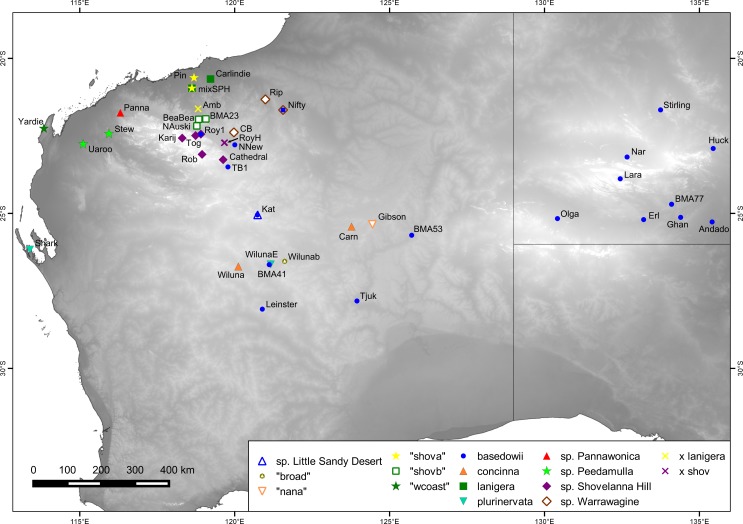
Sampling locations for populations from the Triodia basedowii complex and close relatives.The outgroups T. concinna and T. plurinervata are included. Elevation base map information from [48].